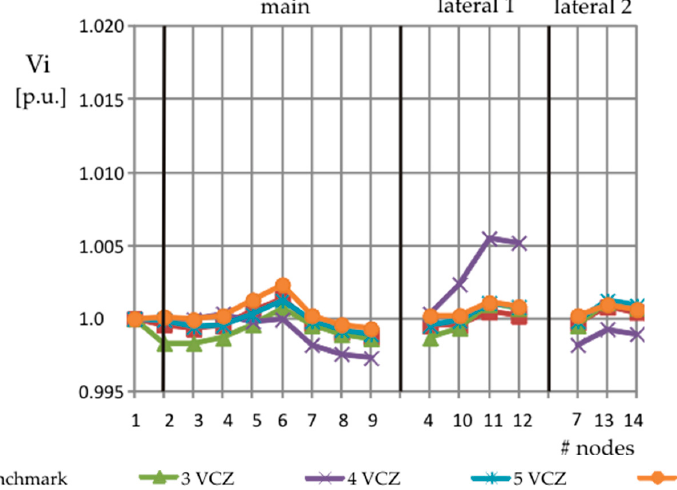
Figure 16. Voltage profiles for Case X —DG and BESSs: P algorithm—feeder 1. Figure 16 : Voltage profiles for Case X — DG and BESSs: P algorithm—feeder 1. Figure 16 : Voltage profiles for Case X — DG and BESSs: P algorithm—feeder 1. Figure 16 : Voltage profiles for Case X — DG and BESSs: P algorithm—feeder 1.